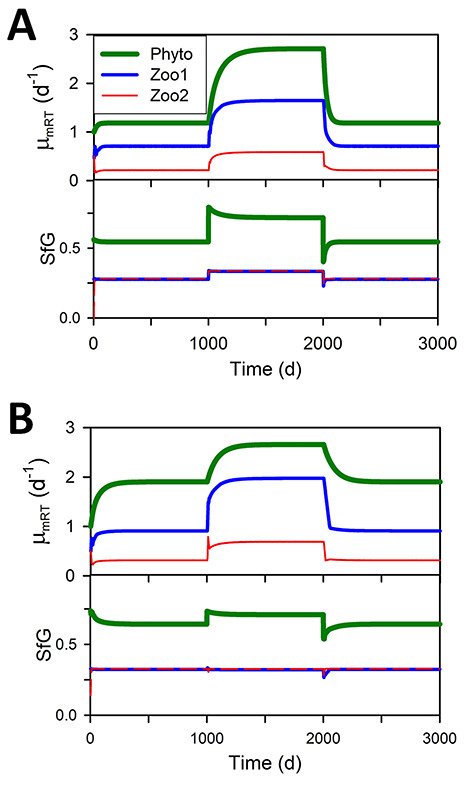
Evolution is reversible and maximum growth rate at the reference temperature (μmRT) at equilibrium is lower for higher trophic levels. Panel A: time course of changes in μmRT and SfG of organisms within the NPZZ simulation subjected to a decrease in stress at time 1000, lowering catabolic respiration (CRconst changes from 0.25 to 0.1) followed by an increase in stress at time 2000 to the original level (CRconst changes from 0.1 to 0.25). Panel B: time course of changes in μmRT and SfG of organisms subjected to a decrease in stress at time 1000 due to changes in energy input from illumination via altering mixed layer water depth (Dep changes from 45 to 5) followed by an increase in stress at time 2000 to the original level (Dep changes from 5 to 45). In both A and B, SfG values for Zoo1 and Zoo2 are closely similar and overlap on the graphs.